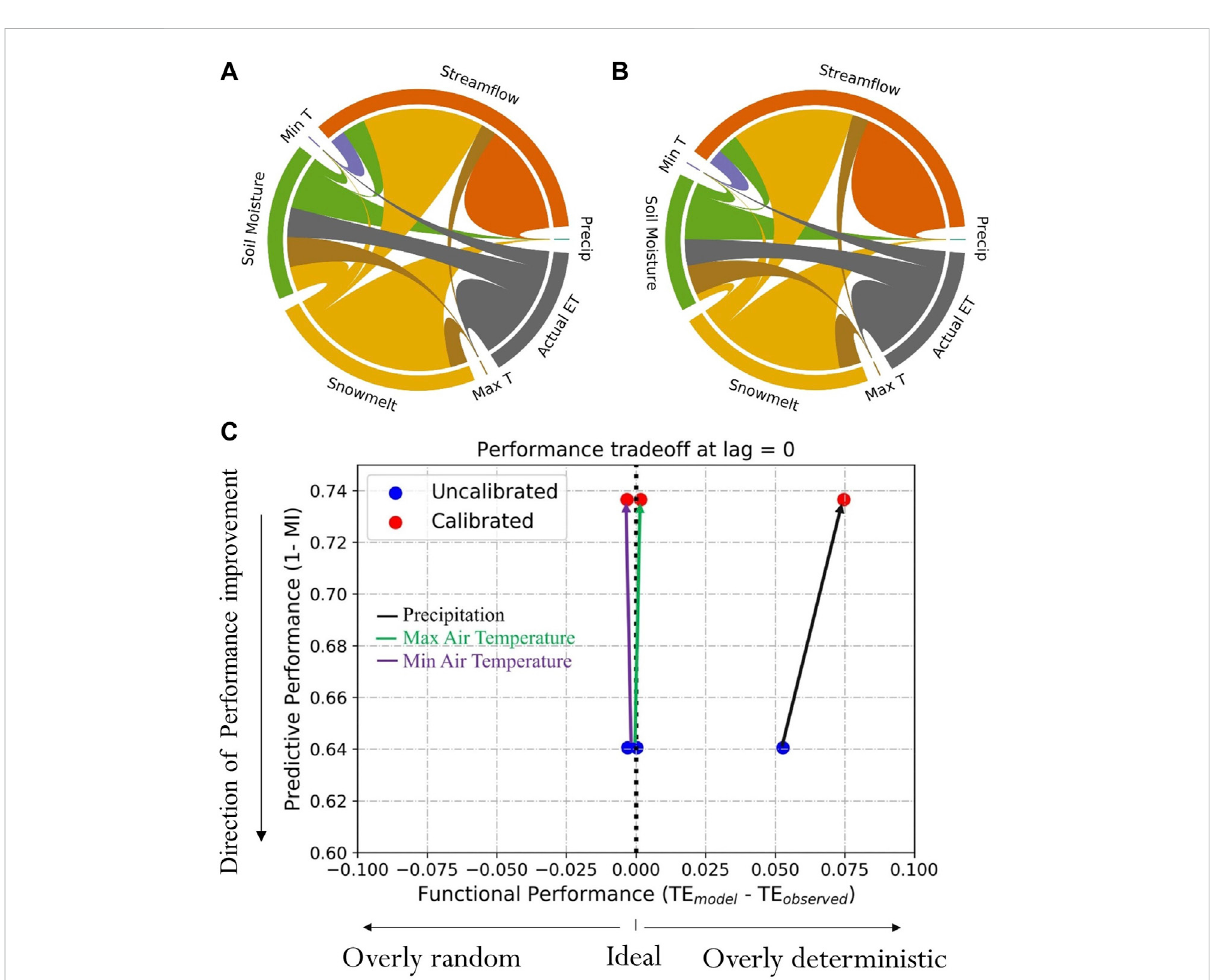
FIGURE 7 Functional performance metrics based on evaluation of NHM-PRMS at the Cedar River watershed. (A) uncalibrated model and (B) calibrated model, and (C) tradeoff between functional and predictive performance metrics. In interpreting PN plots, the outer colored circle indicates the interacting variables. The width of the chords linking the interacting variables corresponds to the TE magnitudes. In (C) , the change in predictive performance and functional performance from the uncalibrated model (origin of the arrow, blue) to the calibrated model (point of the arrow, red) is plotted. Thus, the arrows show the effect of calibration. The difference between the two fi gures is presented in Table 6.